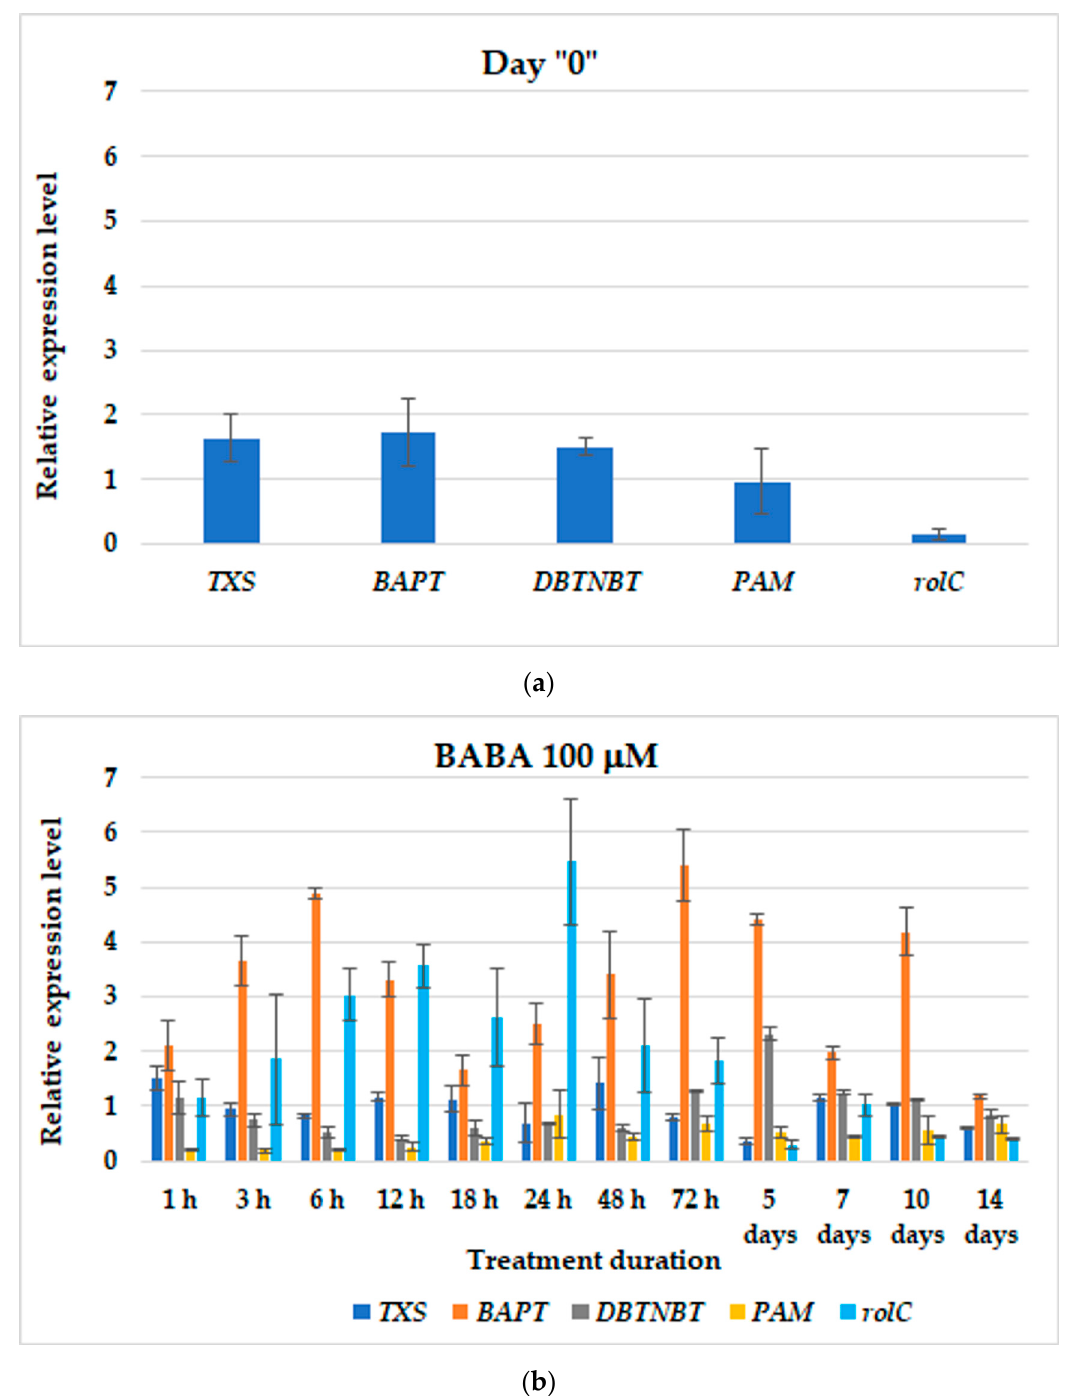
Figure 3. The gene expression profiles in control ( a ) and in 100 µM BABA-treated ( b ) hairy roots. Data represent mean values ± SD from three independent experiments.